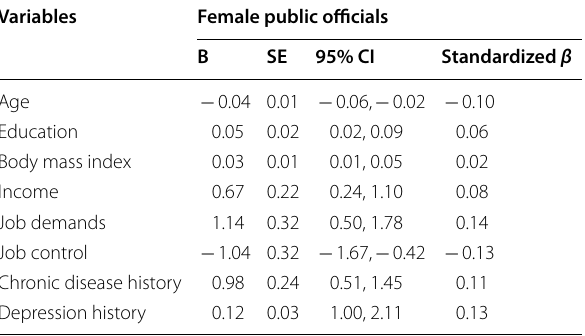
Table 4 Stepwise multiple linear regression for factors predicting the sleep disorders JSEQ score among Egyptian female public officials